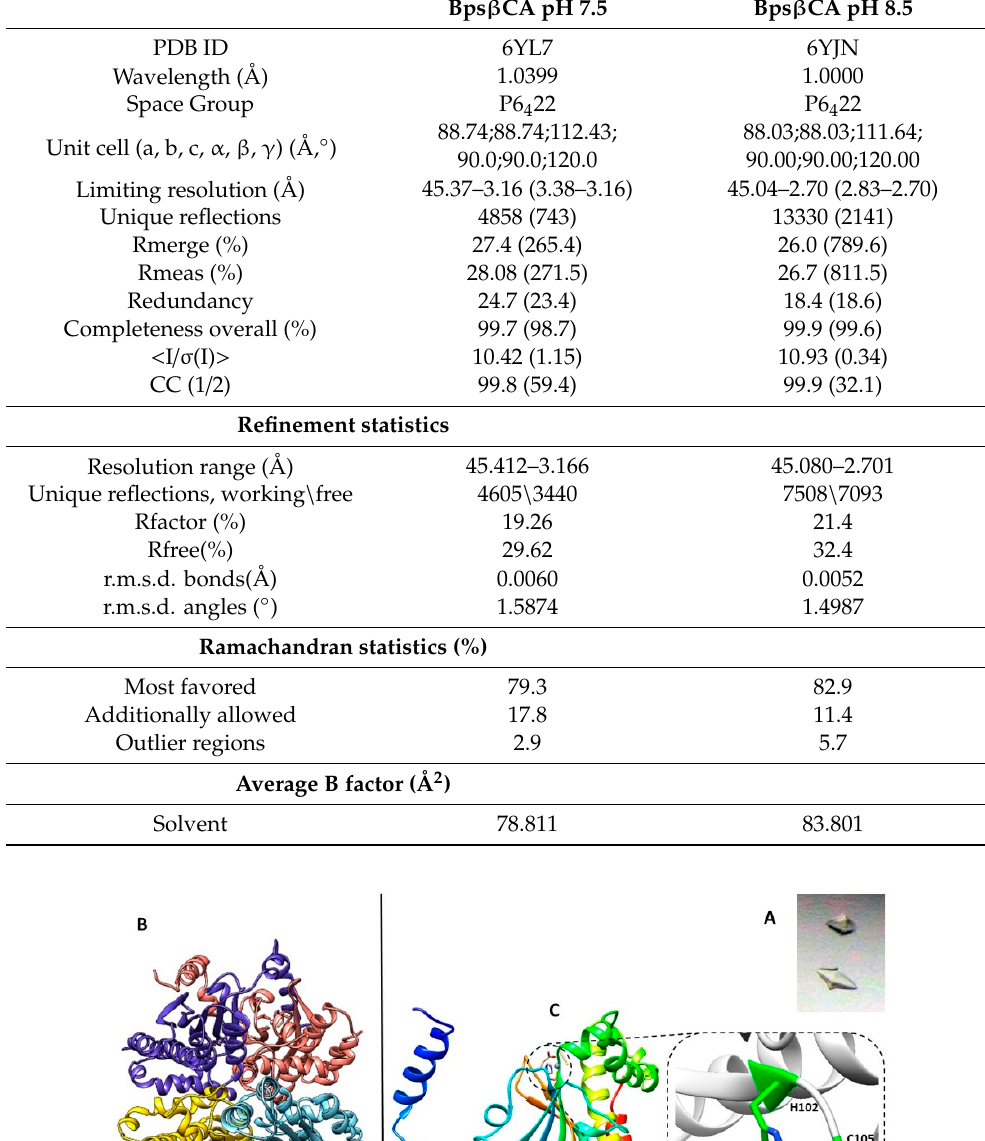
Table 1. Kinetic parameters for the CO 2 hydration reaction catalyzed by the β - and γ -CAs from B. pseudomallei and ι -CA from B. territorii measured at 20 °C, pH 8.3 in 20 mM TRIS buffer, and 20 mM NaClO 4 [20,21,35]. Acetazolamide inhibition data are also shown. Table 2. Summary of Data Collection and Atomic Model Refinement Statistics.